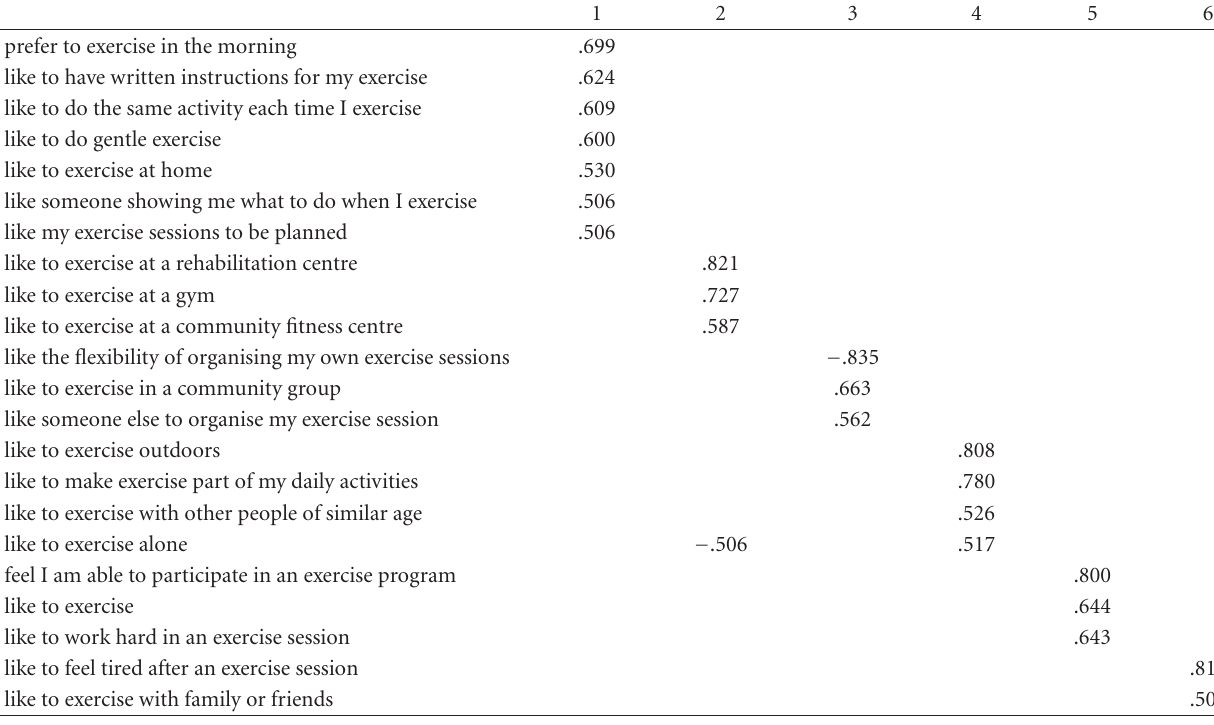
Table 3: Factor analysis loadings used to derive the 6 data-driven factors.